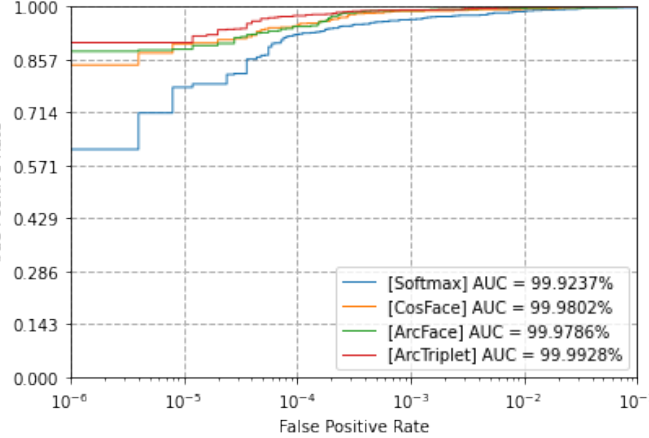
Figure 4. ROC curves of ArcFace + Triplet, ArcFace, CosFace and Sotmax on IITD.